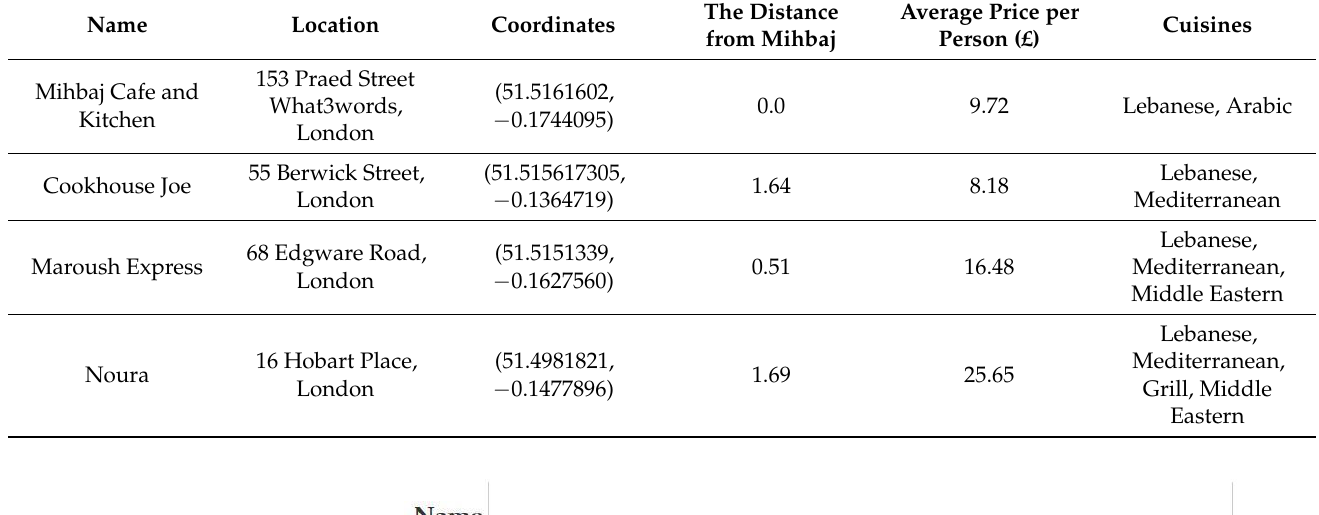
Table 2. Basic information on Mihbaj and its similar entities.